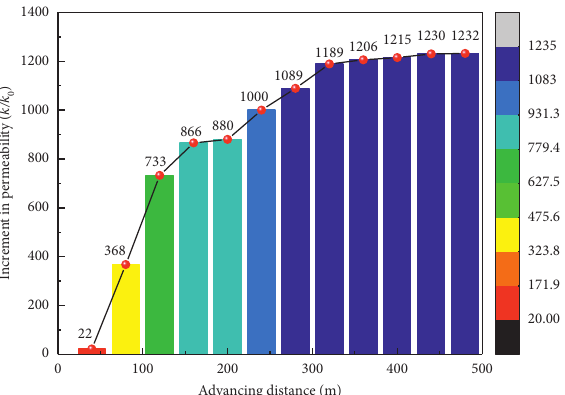
Figure 7: Evolution law of permeability of #3 coal seam.